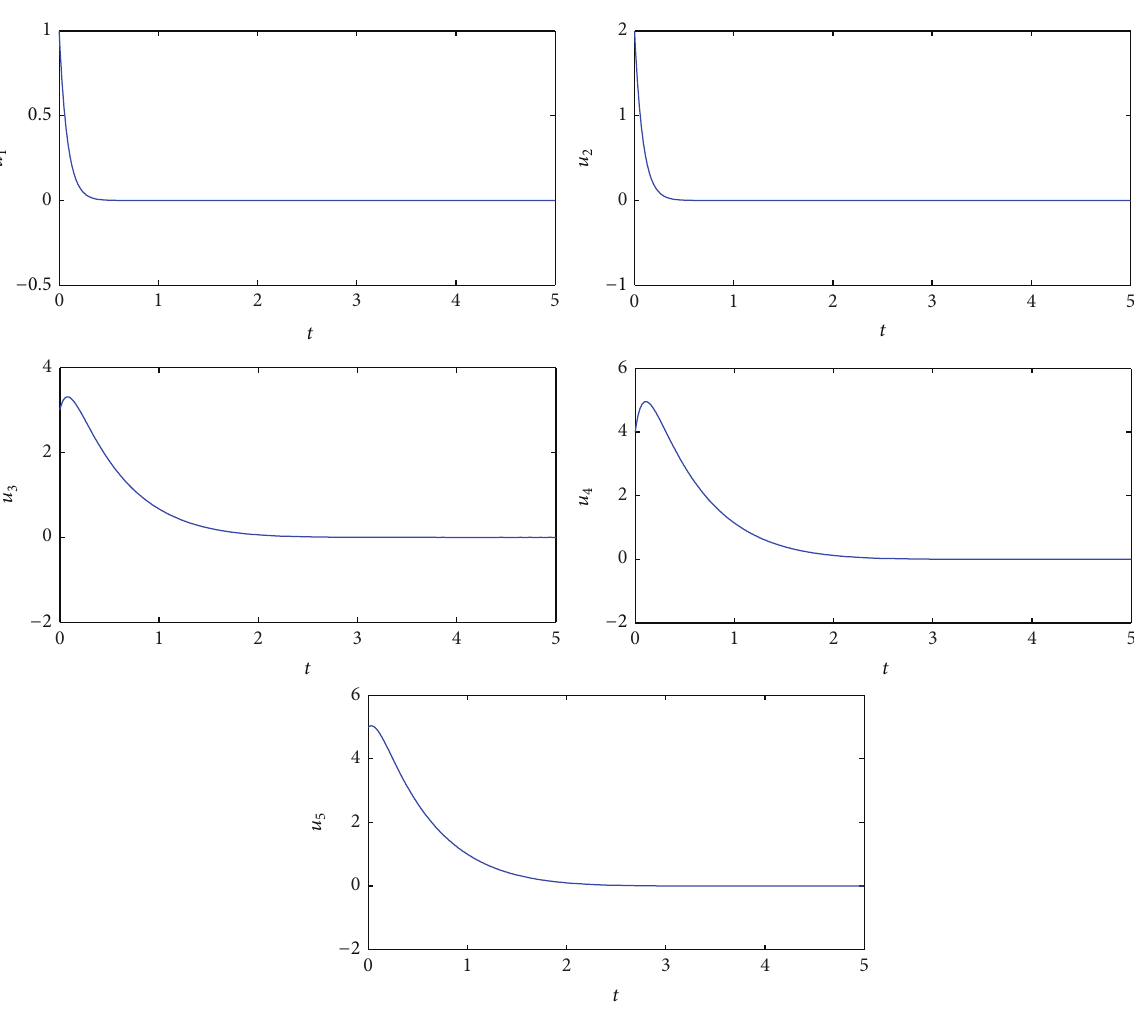
Figure 2: The states of the controlled system (11) with controllers